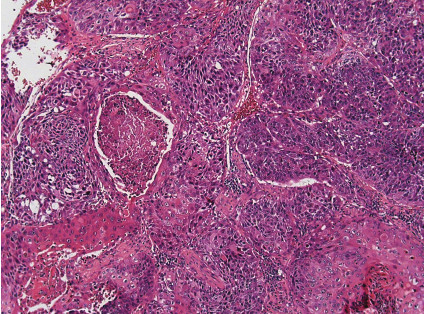
Figure 4: Invasive squamous cell carcinoma showing intense pleomorphism, atypical mitosis, and focal necrosis